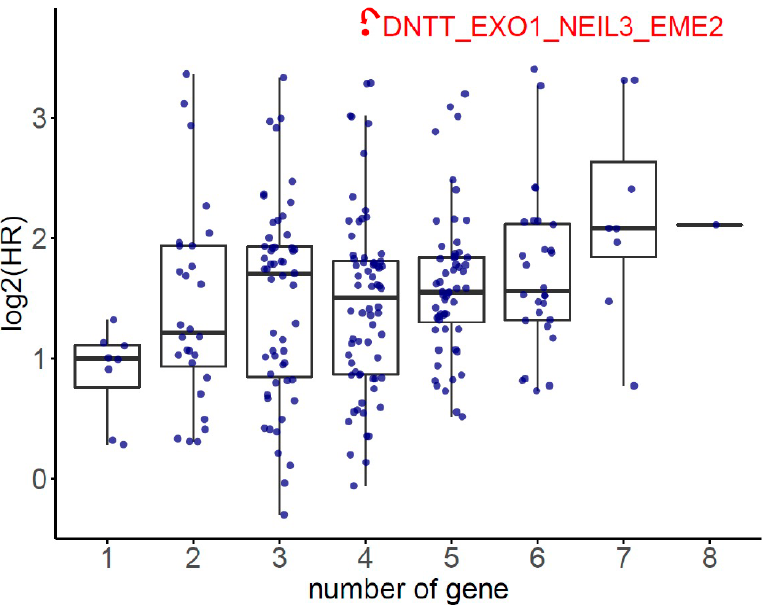
Figure 3. The additive effect on hazard ratio (HR) of overall survival (OS) for each combination of any of the 8 SDE genes.